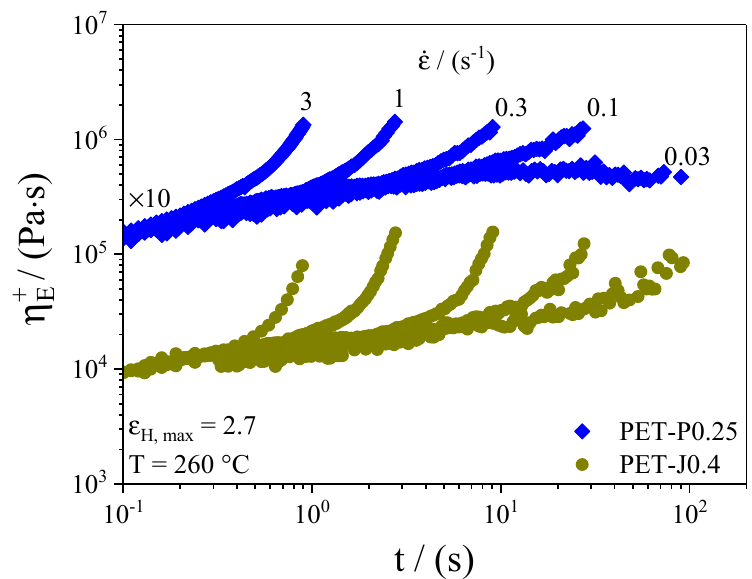
Figure 4. Time-dependent elongational viscosity at different elongational rates for PET-J0.4 and PET-P0.25. The PET-P0.25 curves are shifted by 10, as indicated in the figure.